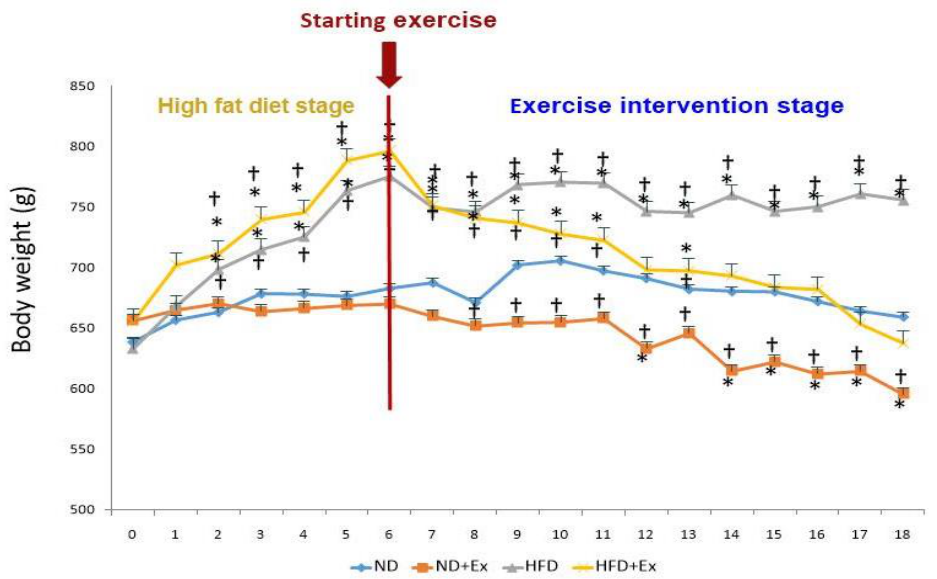
Figure 2. Changes in body weight during high fat diet-induced obesity induction and exercise intervention. *, p < 0.05 vs. baseline by paired t -test; † , p < 0.05 vs. the ND group by independent t -test. ND, normal diet; ND+Ex, normal diet + exercise; HFD, high fat diet; HFD+Ex, high fat diet + exercise.